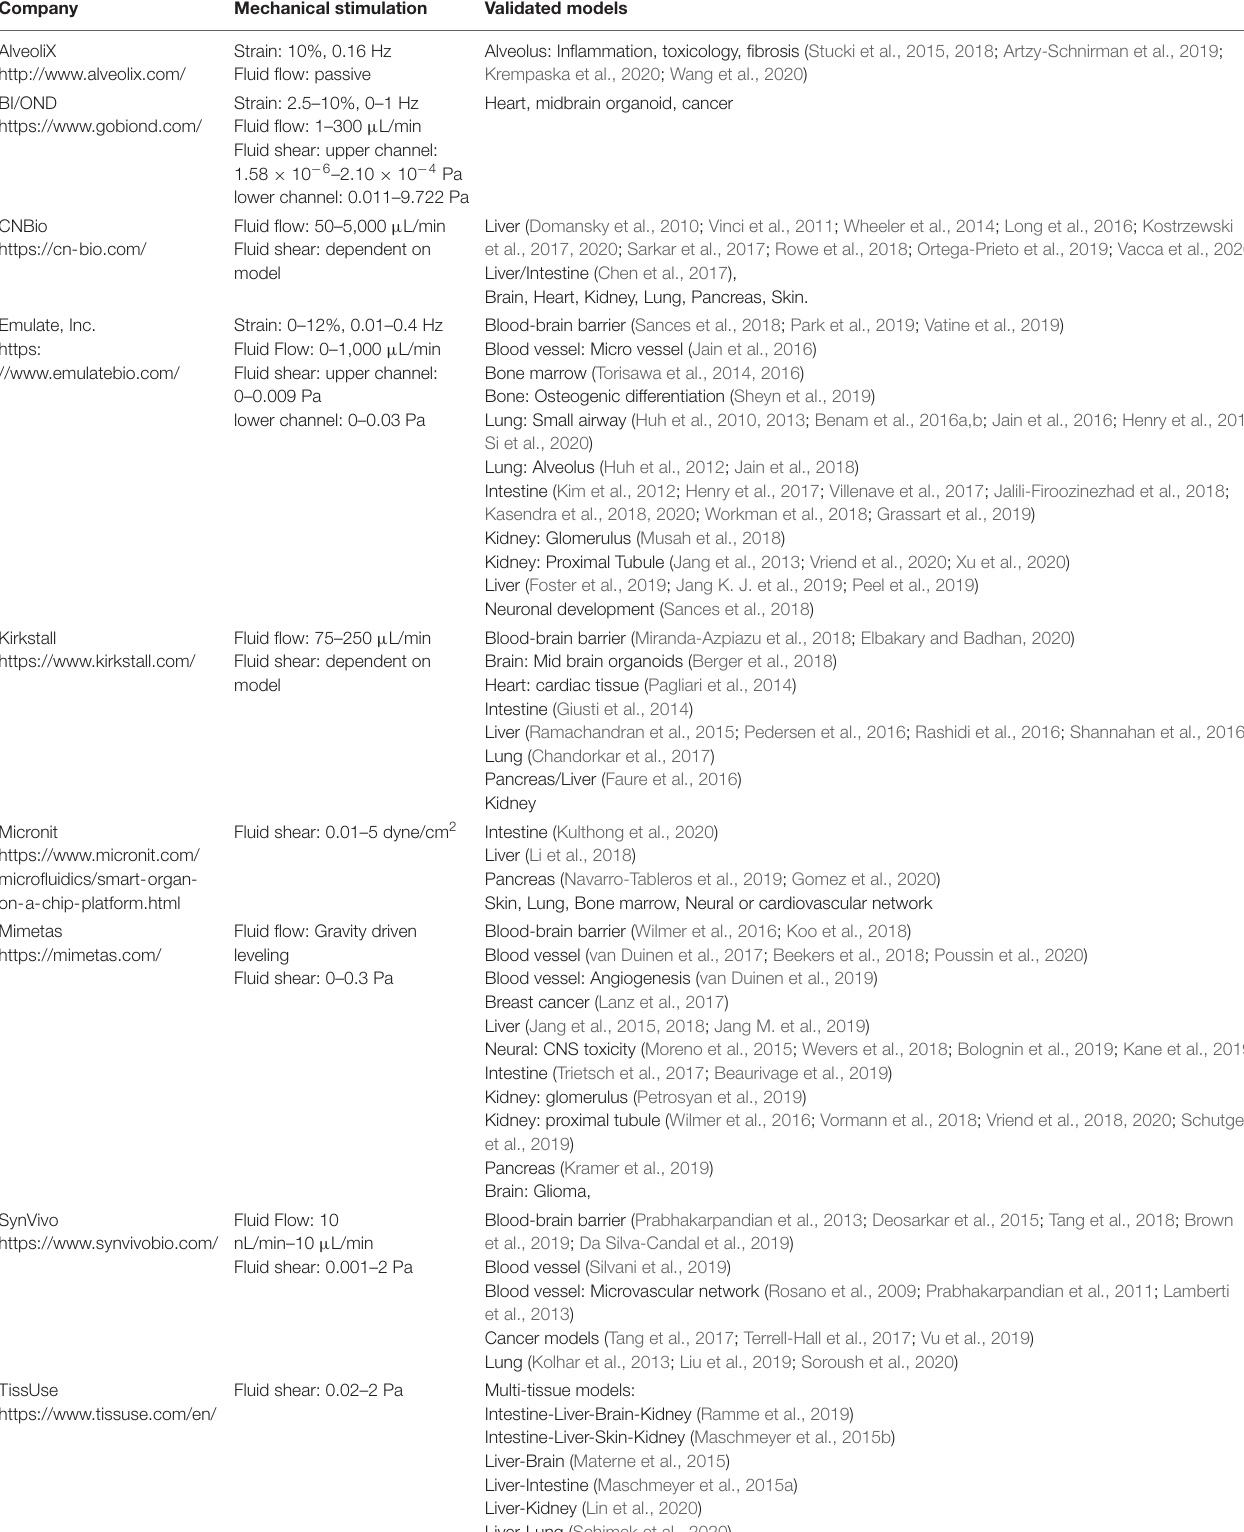
TABLE 1 | Commercially available organ on chip systems with integrated mechanical stimulation.